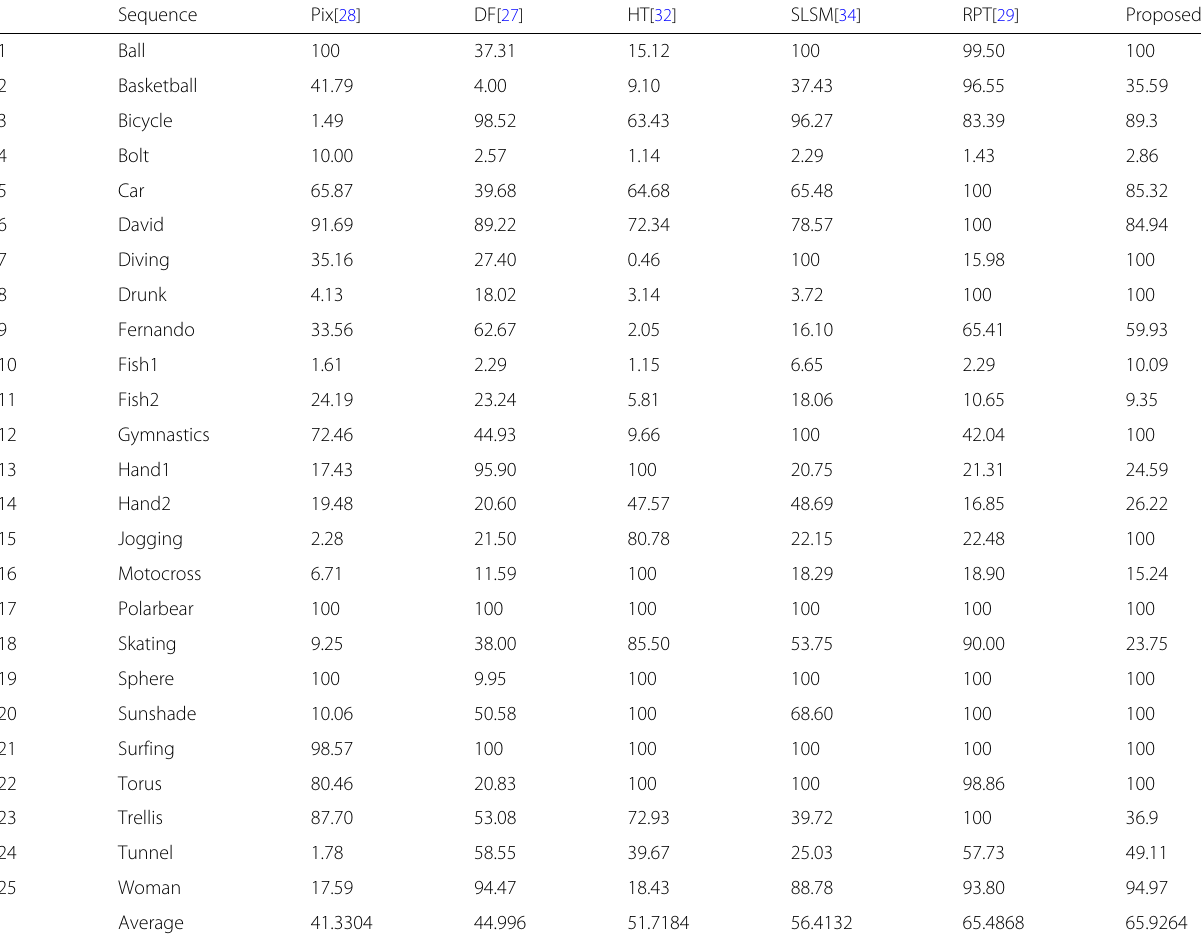
Table 1 Evaluation results of the compared methods on VOT2014 dataset: percentage of correctly tracked frames (score > 0.5) Sequence